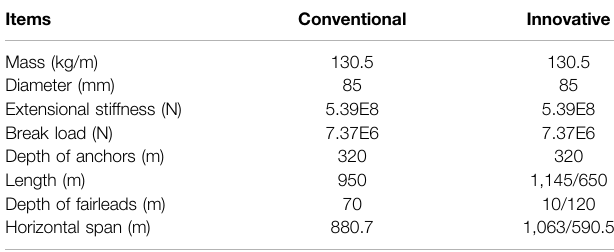
TABLE 2 | Parameters of mooring lines Items